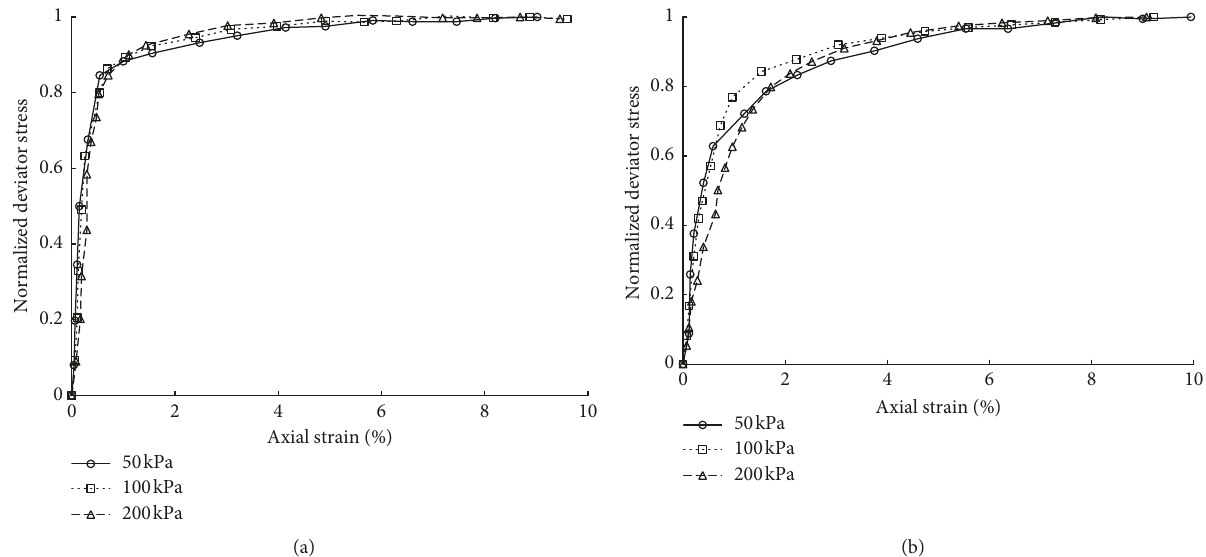
Figure 14: Normalized stress-strain curves: (a) unconsolidated-undrained triaxial shear test; (b) consolidation-undrained triaxial shear test.